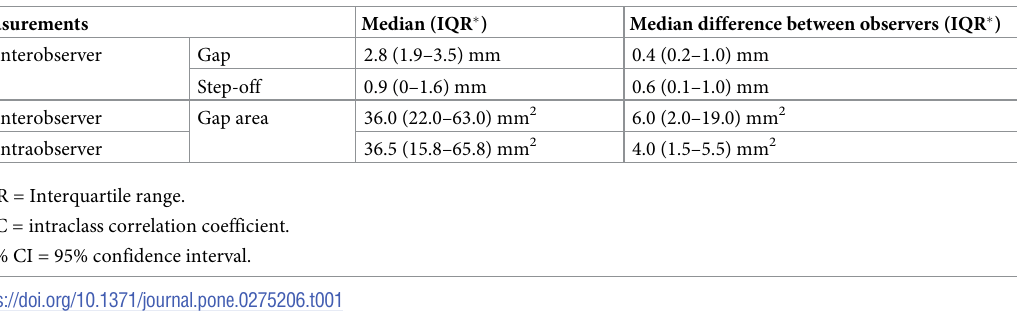
Table 1. Inter- and intraobserver